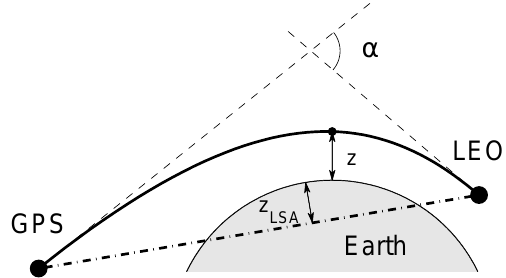
Fig. 1. Schematic diagram of the occultation geometry. Ionospheric and atmospheric refraction deflects the ray (solid line) by bending angle α . z denotes the altitude of the ray tangent point above the ellipsoid, z LSA the line-of-sight (dashed-dotted) altitude. Note that in the lower troposphere z LSA may become negative. (Figure is not to scale.)